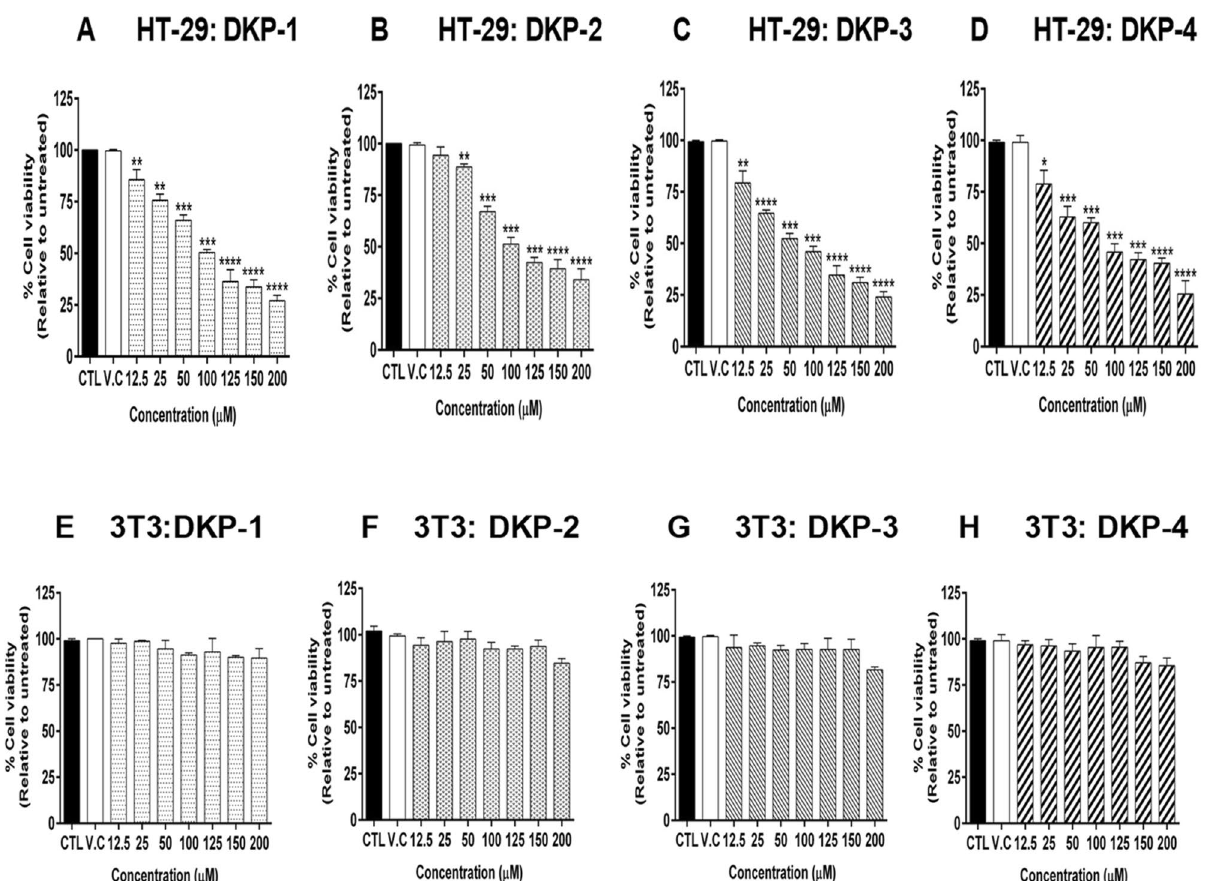
Figure 2. Cell viability in cells treated with cyclic dipeptides (DKPs). ( A – D ) Colorectal cancer HT-29 cells were treated with different doses of DKP-1: cyclo (l-Pro-l-Leu) ( A ), DKP-2: cyclo (l-Pro-l-Val) ( B ), DKP-3: cyclo (l-Pro-l-Phe) ( C ), and DKP-4: cyclo (l-Pro-l-Tyr) ( D ) for 24 h. ( E – H ) Normal mouse fibroblast 3T3 cells were treated with different doses of DKP-1 ( E ), DKP-2 ( F ), DKP-3 ( G ), and DKP-4 ( H ) for 24 h. Cell viability was determined relative to the untreated cells or vehicle control. Data were expressed as mean ± SD (n = 3). Data were analyzed by one-way ANOVA with student’s two-tailed t -test. The asterisks * p < 0.05, ** p < 0.001, *** p < 0.0001, **** p < 0.0001, indicates a significant difference between the control in response to DKPs treaments. CTL Control; VC Vehicle control